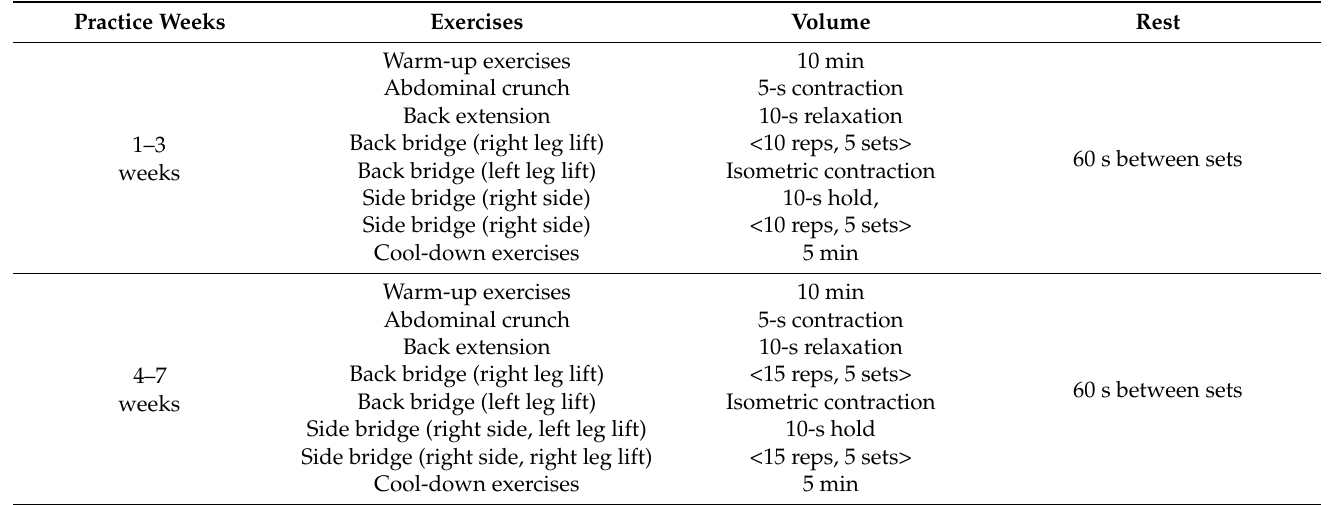
Table 2. 7 weeks core exercise program.